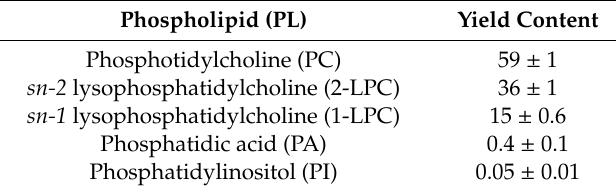
Figure 4. Analysis of the enzymatic hydrolysis of phospholipase B using Lecithin (Soybean) by 31 P NMR. The experiment was done in triplicate at three different time intervals. The error bar represents the mean SD± of the experiment ( n = 3). Table 2. Analysis of the enzymatic hydrolysis of phospholipids in Lecithin (Soy bean) by 31 P NMR.